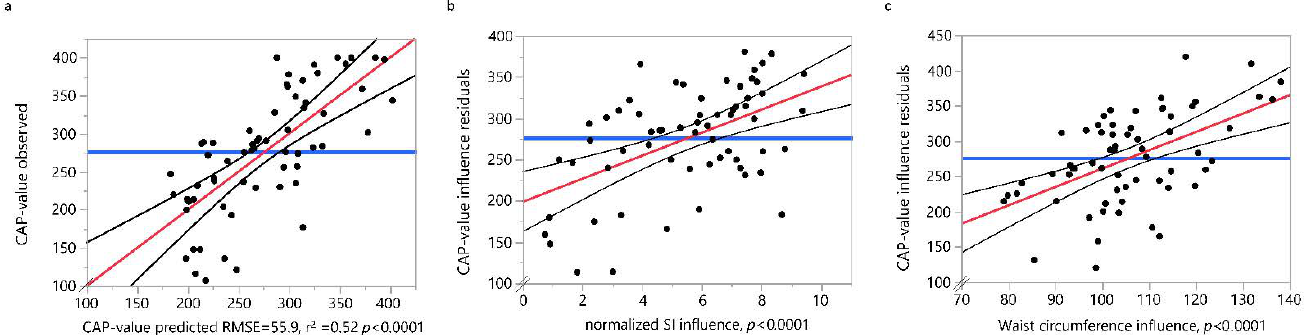
Figure 4. Linear fit of the observed CAP-values by the predicted values ( a ) for the linear regres- sion model with the normalized SI ( b ) and waist circumference ( c ) as influencing factors. Values (black dots), regression line (red line) and 95% confidence intervals for the regression (black curved lines) are shown. RSME = Root Mean Square Error. SI = snoring index, CAP-value = continuous attenuation